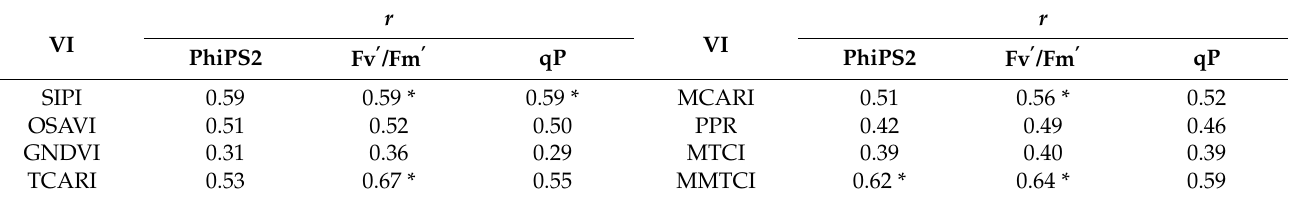
Table 2. Coefficientsofcorrelation( r